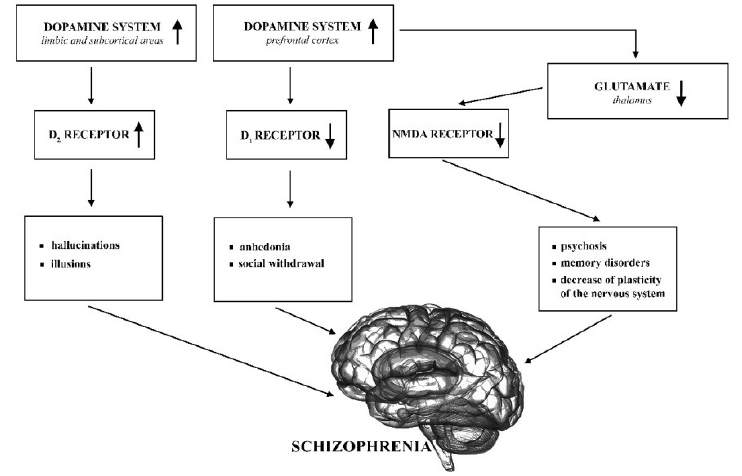
Figure 1. Dopaminergic and glutamatergic system abnormalities in schizophrenia (SZ). NMDA: N-